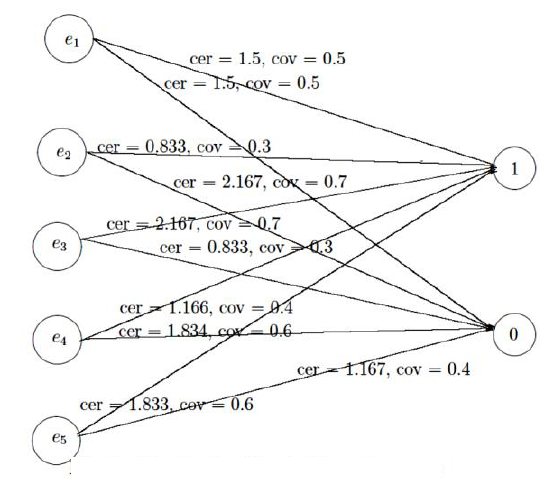
Fig. 1. Flow graph with certainty and coverage.